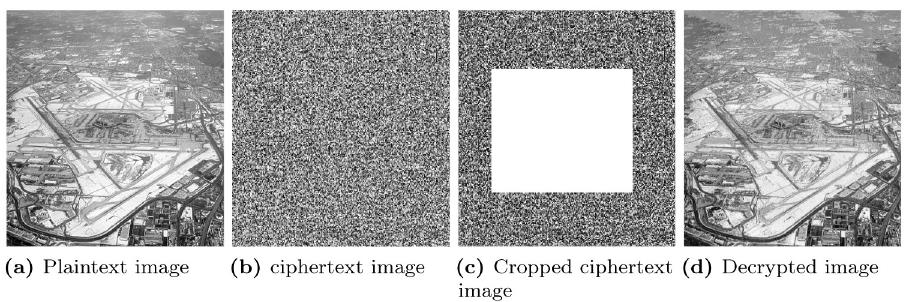
Fig 10. Cropping attack analysis. (a) Plaintext image, (b) ciphertext image, (c) Cropped ciphertext image, and (d) Decrypted image.